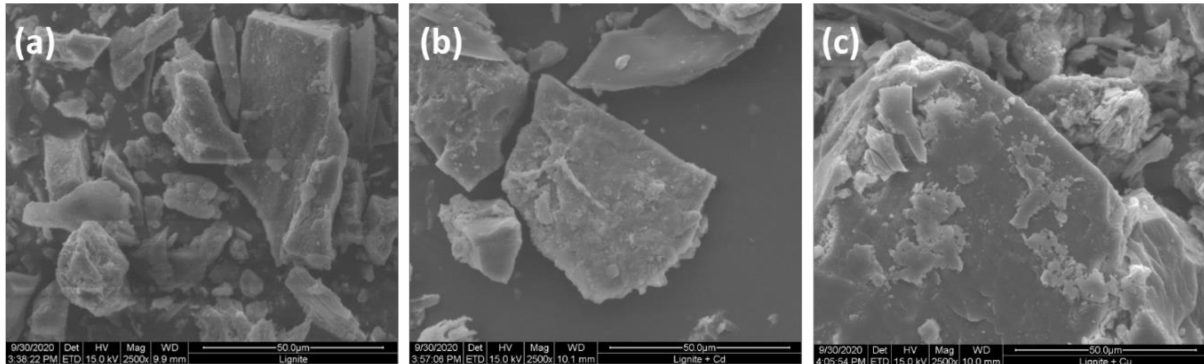
Figure 7. SEM images of: ( a ) raw lignite; ( b ) after adsorption of cadmium; ( c ) after adsorption of copper (magnitude: ×